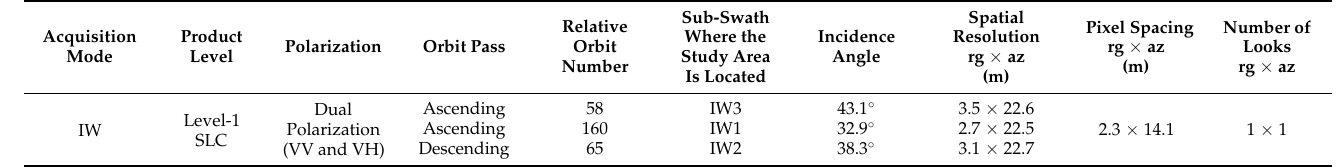
Table 1. Characteristics of Sentinel-1 satellite images used in the study [54].